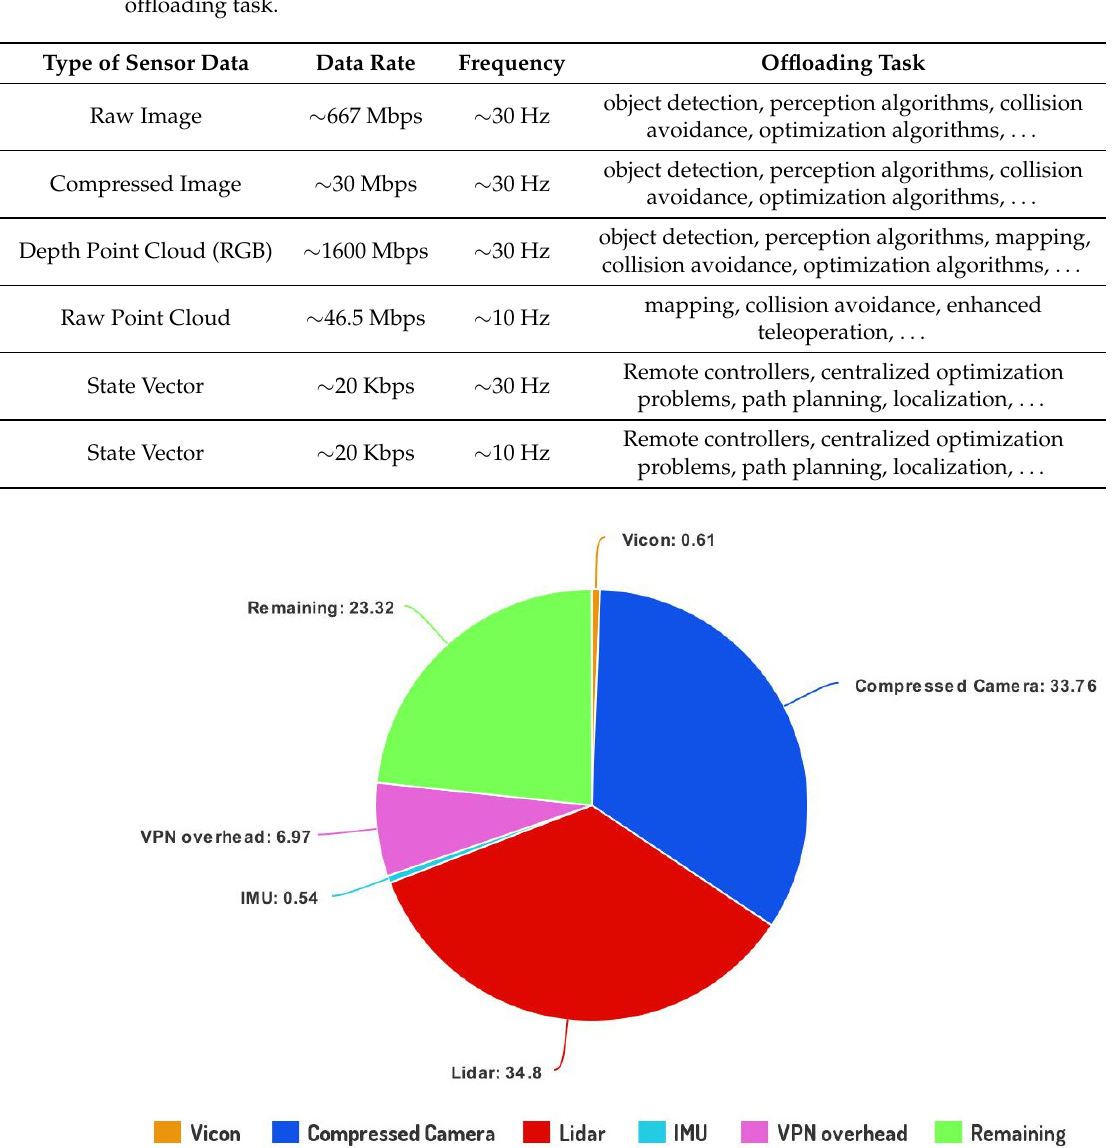
Figure 5. Pie chart that describes the allocation for the average sensor data production of a capable 5G-UAV platform considering the available uplink capacity. Note that the achievable throughput requires high signal strength values and low